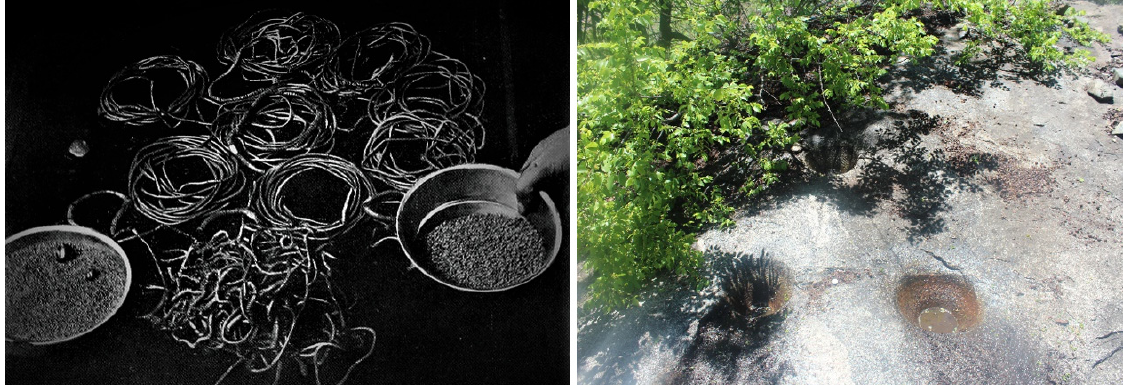
Figure 6. Remnants of gold objects that were looted at Mundi by the Rhodesia Ancient Ruins Company [36] (pp. 94–250), and dolly holes that we recorded near the Mutabvuri homestead in Mberengwa.